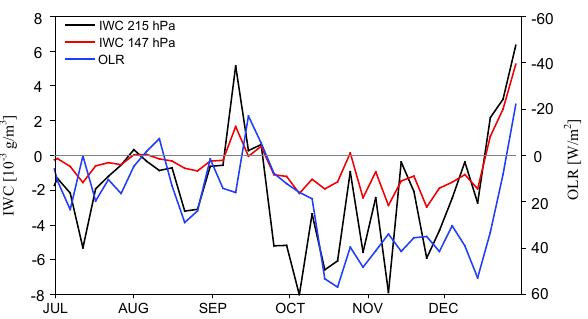
Fig. 2. MLS cloud ice water content (IWC) at 147hPa and 215hPa and NCEP/NCAR outgoing longwave radiation (OLR), calculated as the differences between 2006 and 2005. Values are averages over the Indonesia domain (see Fig. 1). Interpolated OLR data pro- vided by the NOAA/OAR/ESRL PSD, Boulder, Colorado, USA, from their website at http://www.esrl.noaa.gov/psd/.